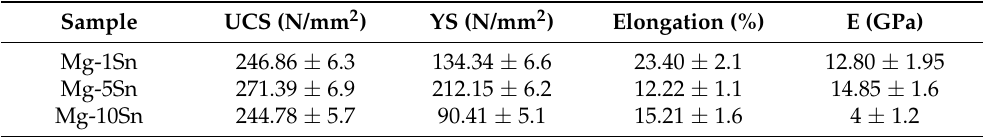
Table 1. Mechanical properties of Mg-Sn